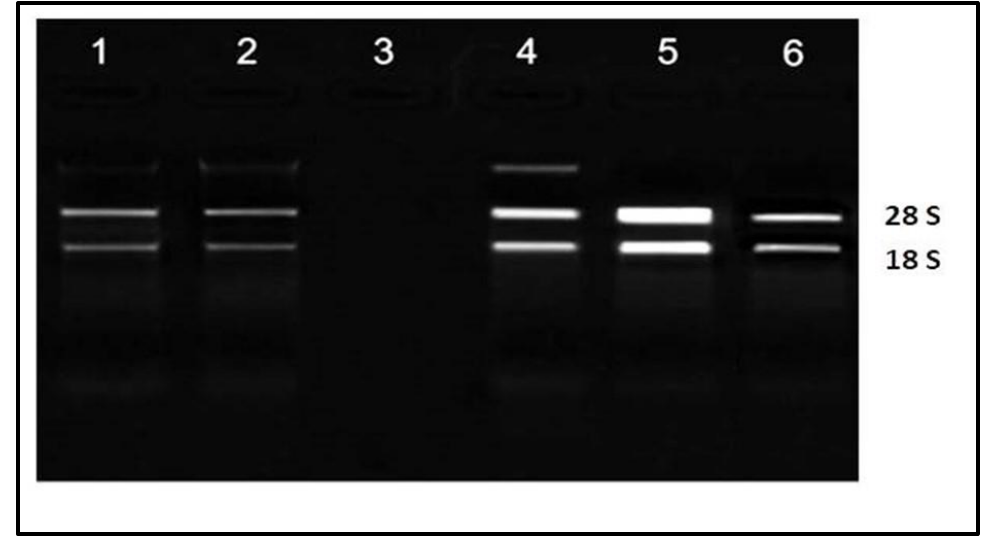
Figure 5. The 28S and 18S RNA bands of extracted RNA from leaves of Moringa oleifera .